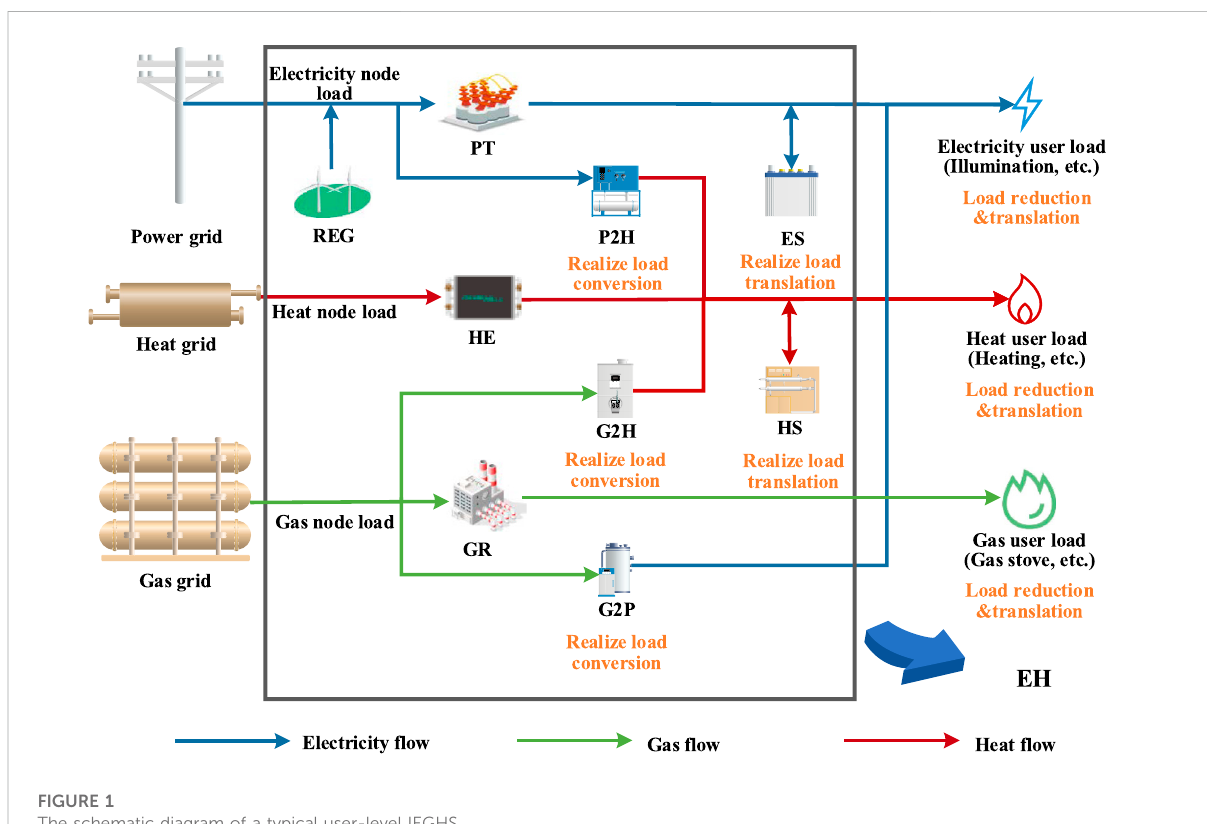
FIGURE 1 The schematic diagram of a typical user-level